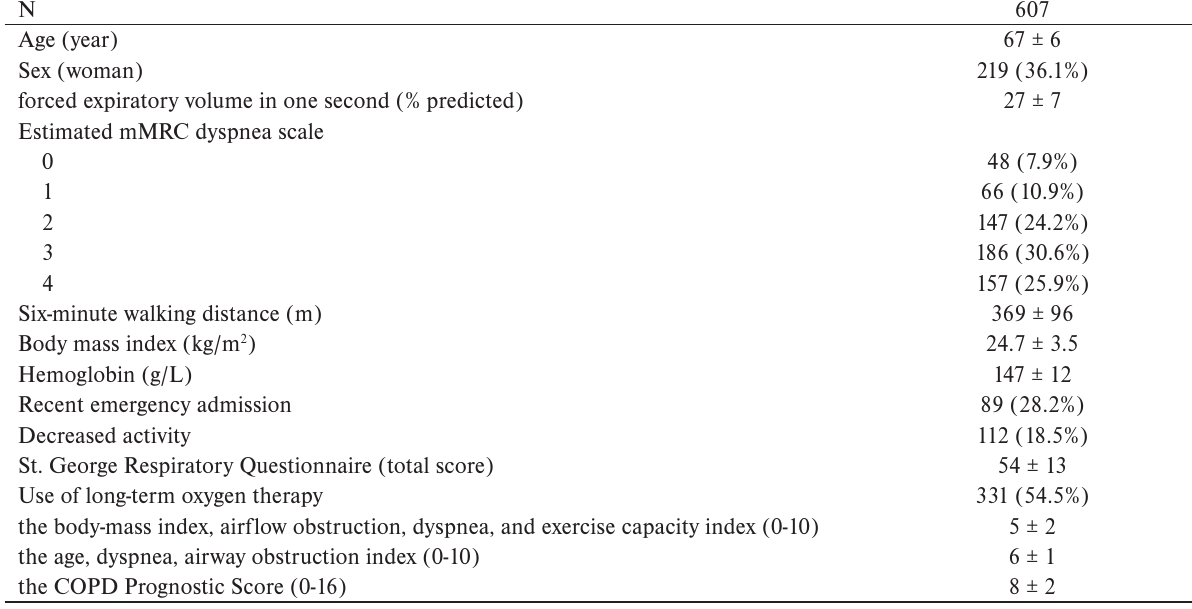
Table 3. Background patient characteristics.